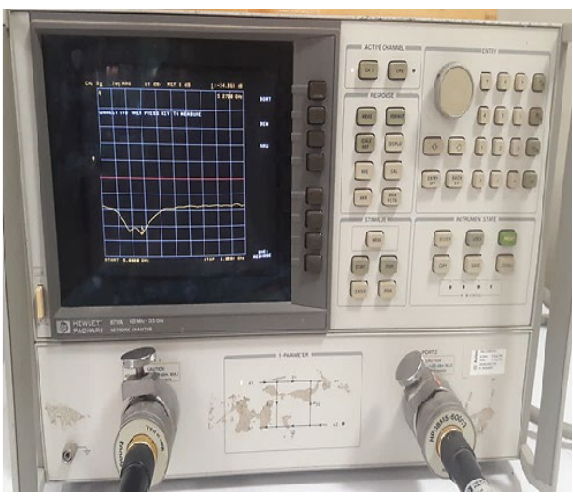
Fig. 15. Measured return loss for the CP antenna for 5G